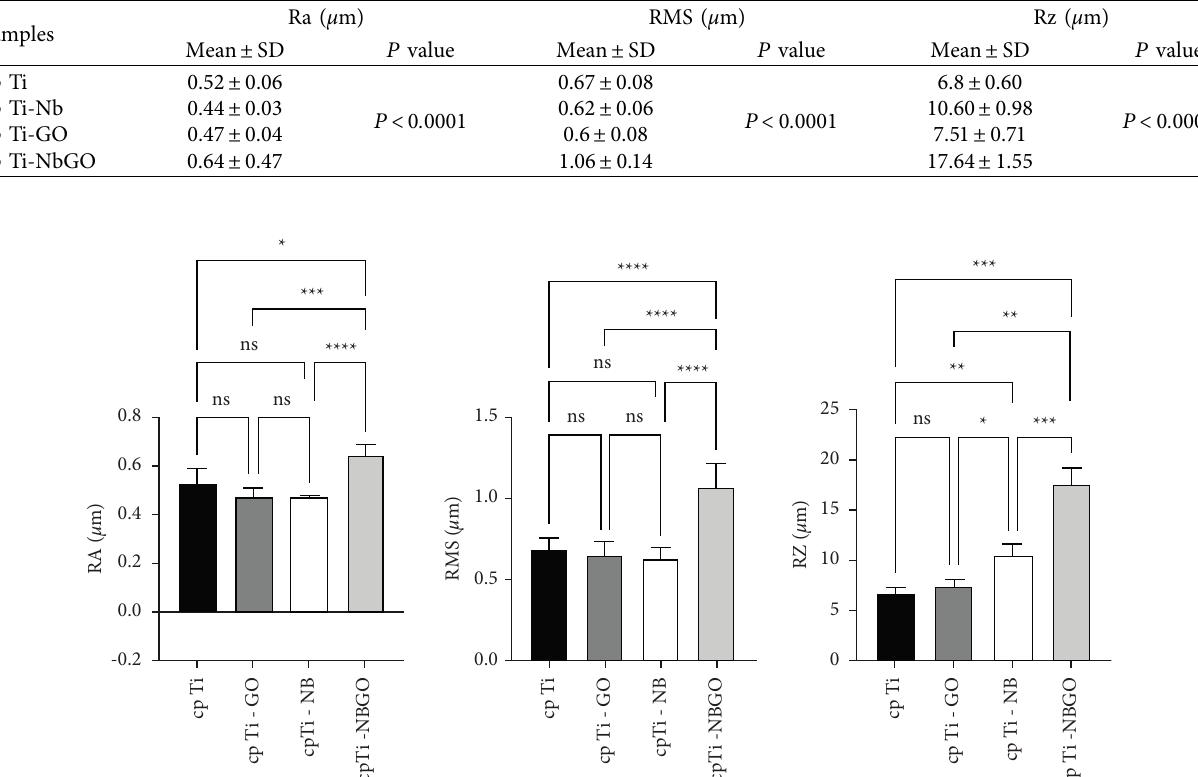
Figure 8: Tukey’s statistical analysis of roughness parameters Ra, RMS, and